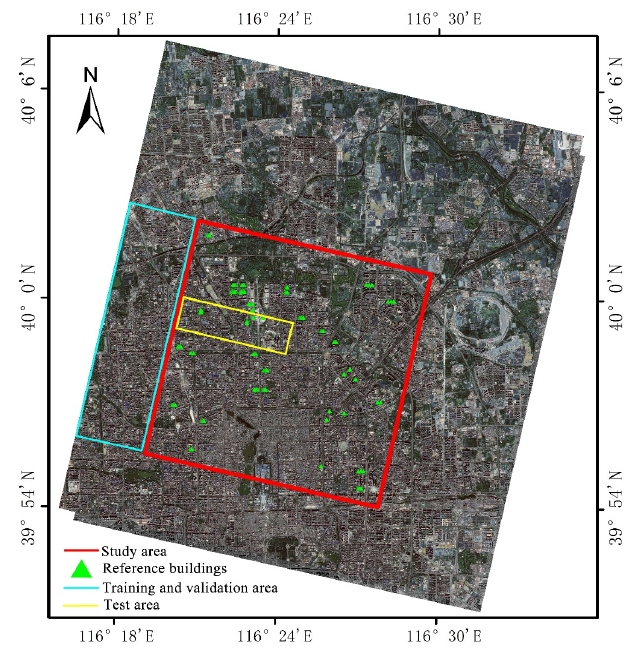
Figure 1. GF-7 multi-spectral and multi-view image of the study